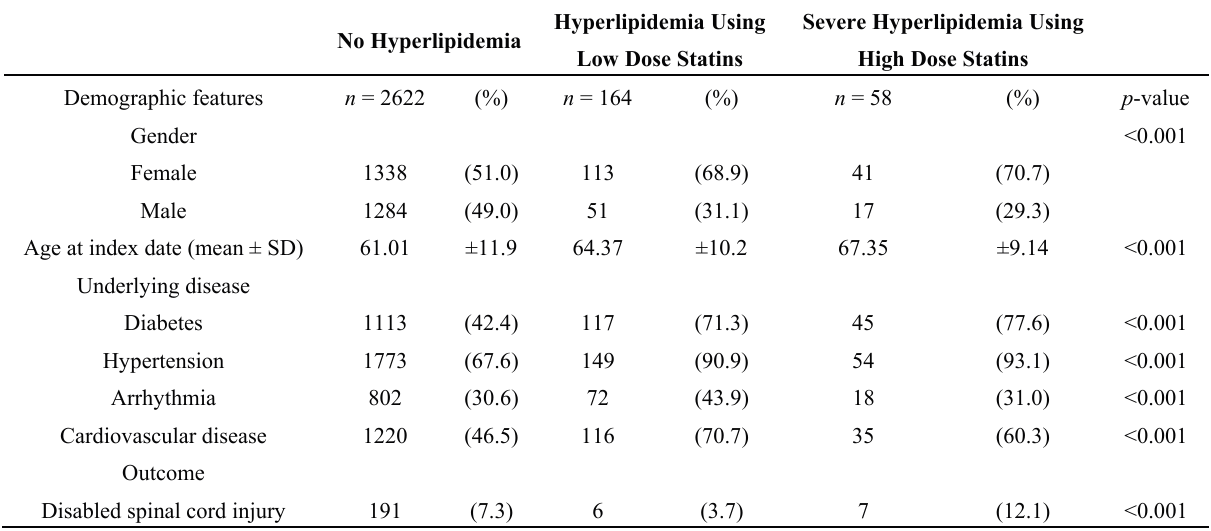
Figure 1. Flow of data processing (1998–2010, Lumbar spine fracture with nerve injury). Table 1. Demographic features of patients with lumbar spine injury ( n = 2844, 1998–2010,